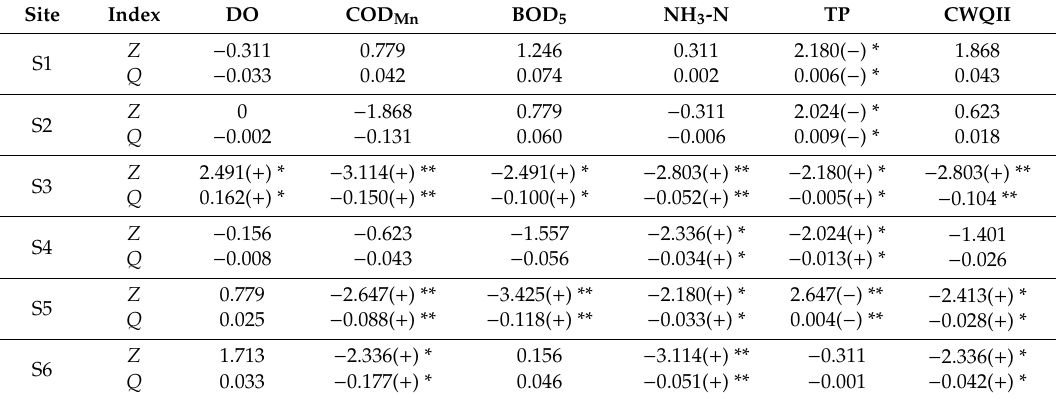
Table1. ResultsoftrendanalysisforfivewaterqualityparametersandCWQIIovertheperiod2005–2015. Table 1. Results of trend analysis for five water quality parameters and CWQII over the period 2005– 2015 .